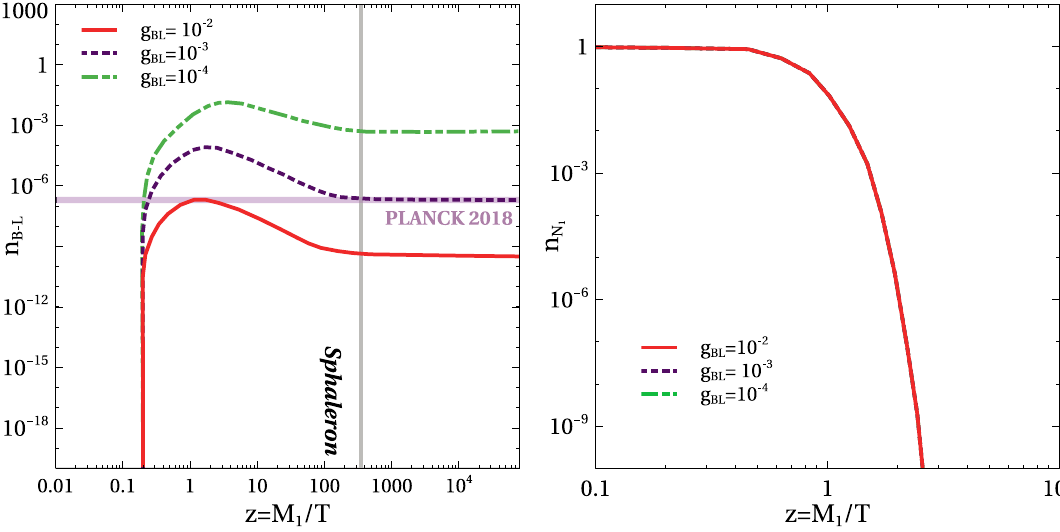
Fig. 2 Variation of CP asymmetry parameter (cid:13) 1 and the decay param- eter K N with M 1 for different values of the N 1 Yukawa coupling 1 (left panel) and for different values of the N 2 Yukawa coupling (Right panel). K N is shown by the solid lines and the (cid:13) 1 is shown with the 1